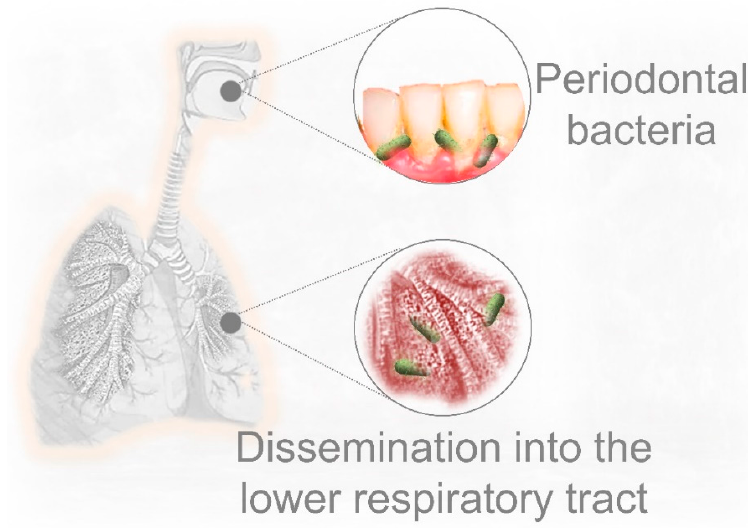
Figure 2. Established periodontal disease is an important source of pathogenic bacteria that can influence the onset and development of lung infection. Periodontal bacteria can disseminate into the lower respiratory system as a consequence of saliva or food aspiration, especially in older individuals, but also inoculation during endotracheal intubation. P. gingivalis is a prominent Gram- negative pathogen implicated in the development of periodontal disease, with highest prevalence in elderly people.